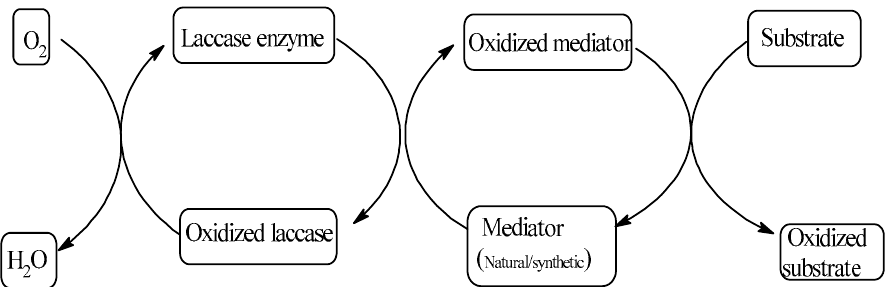
Figure 6. Schematic representation of laccase-catalyzed redox cycles according to which laccase is oxydize in presence of oxygen, itself oxidizing the mediator, and the oxidized mediator further initiates the oxidation of the substrate, with high redox potential [ 131 ] .